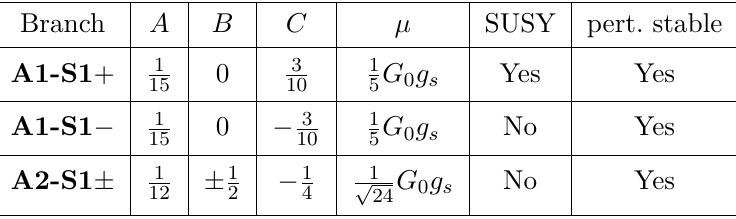
Table 1 . Different branches of S1 solutions found in